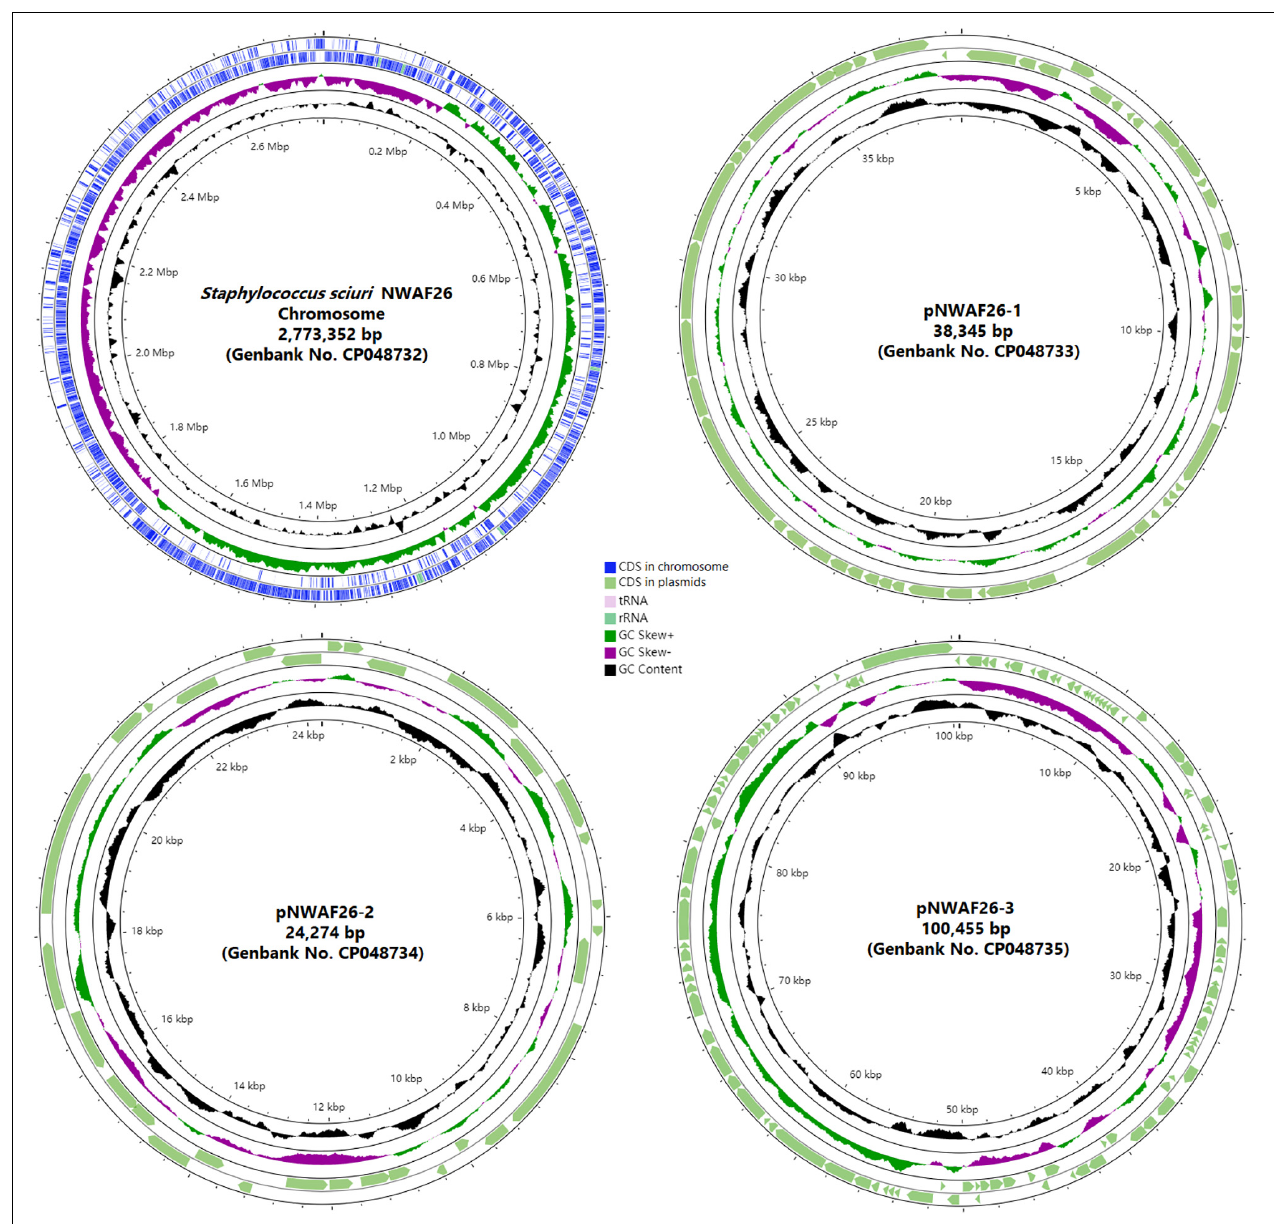
FIGURE 3 | Physical map of the S. sciuri NWAF26 chromosome and three